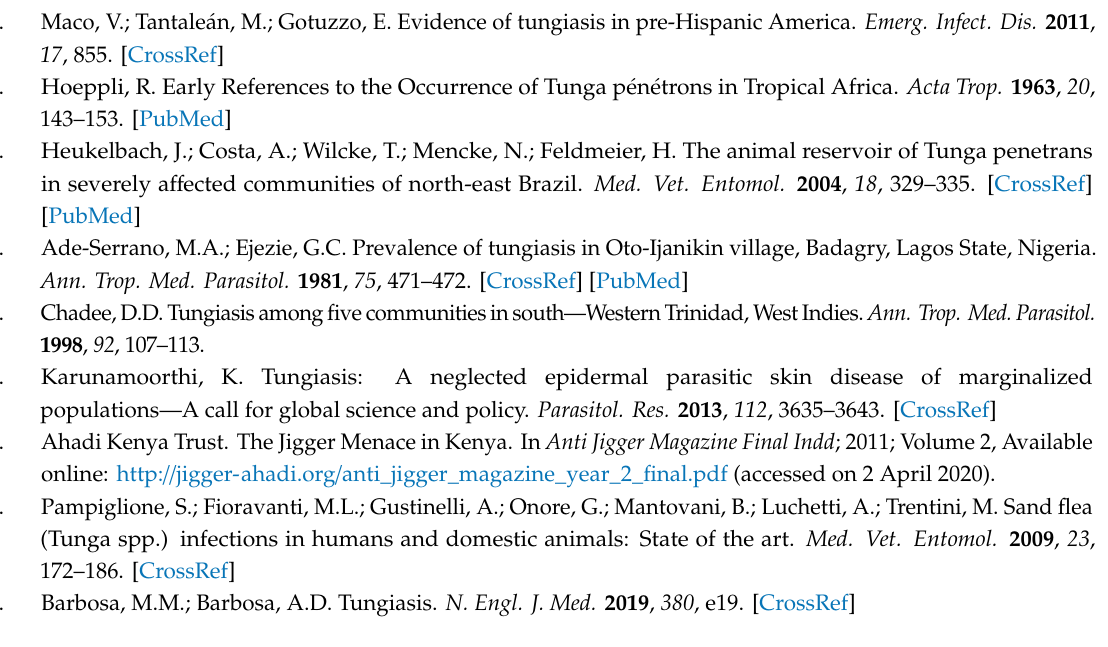
Table S1: Modeling algorithm predictive performance (ROC, TSS, and KAPPA). Map S1: Model Uncertainty Map (Coe ffi cient of Variation). Map S2: Binary (presence / absence)—weighted mean threshold: 0.438. Table S2: Tungiasis occurrence locations in SSA (n =